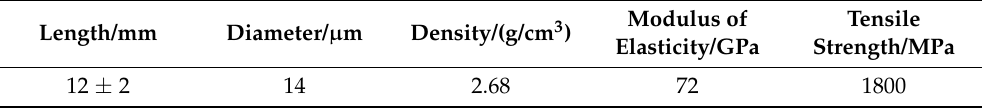
Table 1. Physical and mechanical properties of alkali-resistant glass